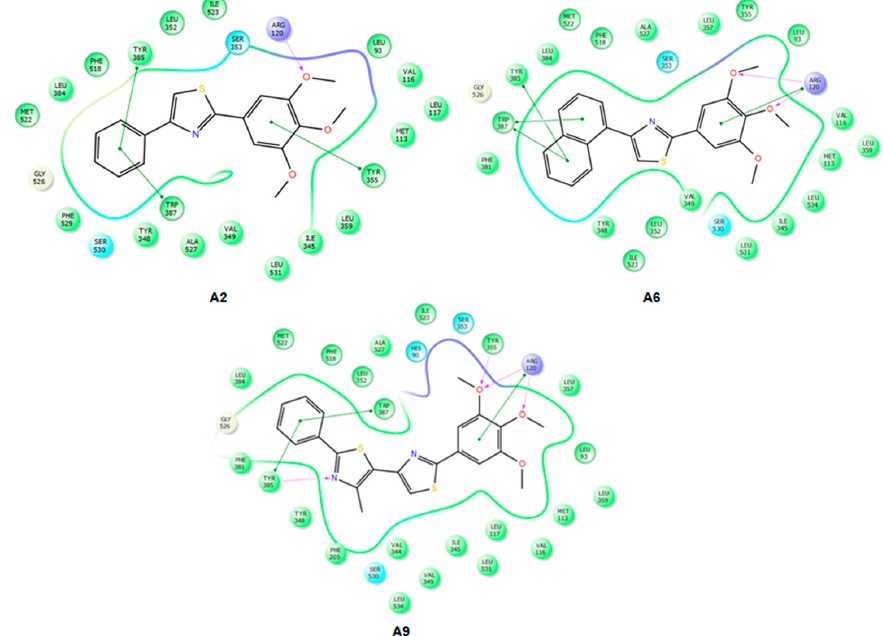
Figure 6. 2D projections of the interactions of compounds A2 , A6 and A9 with the active site of COX-1 (4O1Z).